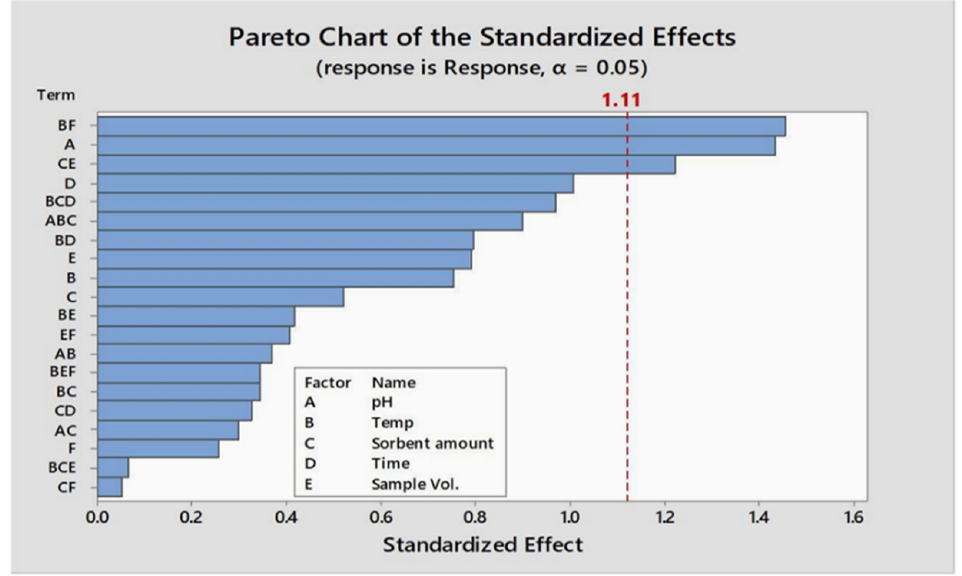
Figure 1. Pareto chart of the factorial experimental design for the analysis of parameter.